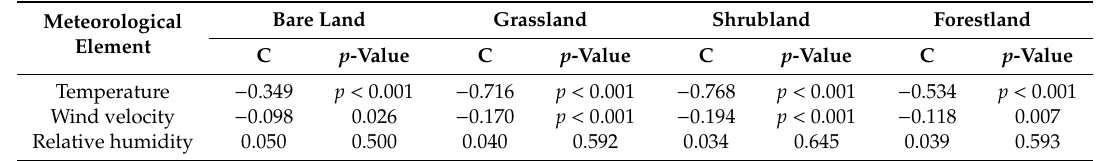
Table 15. Results of the Spearman correlation analysis and the significance level of the relation between volumetric soil moisture content and temperature and wind velocity in a continuous period without rainfall in the dry season, and relative humidity in a period with little rainfall in the rainy season. Meteorological Element